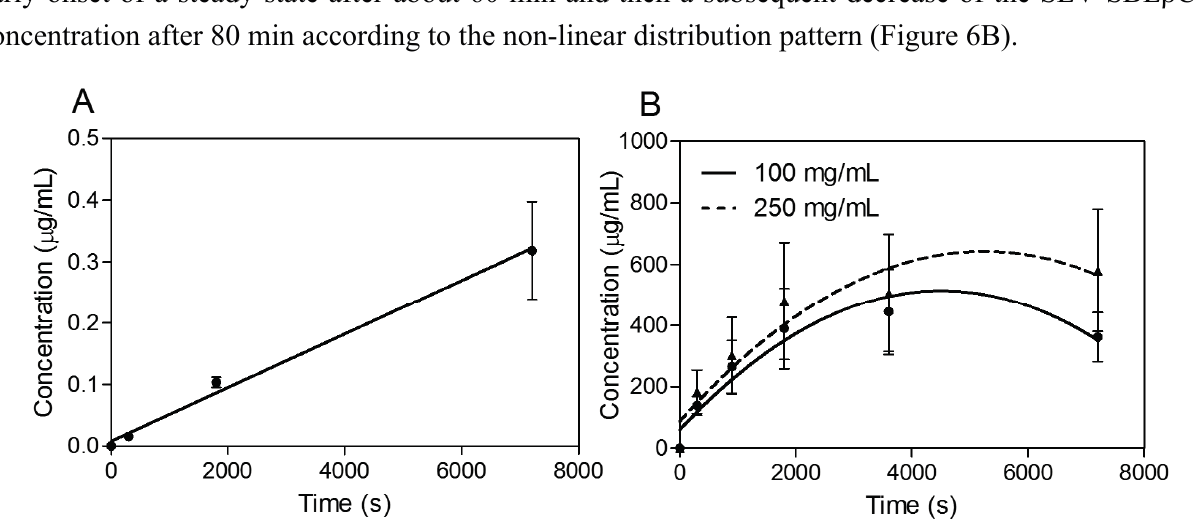
Figure 6. Transwell ® BBB transport studies of propranolol as a system validation substance ( A ) and SEV-SBE β CD ( B ). Collagen 4-coated empty inserts were used as a control. Second-order polynomial (quadratic) curves are implemented to connect and fit the data points. Data represent means ± standard deviation of three independent